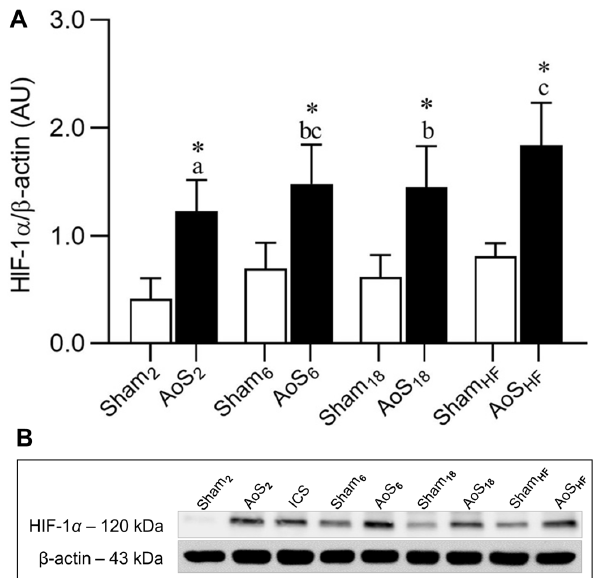
Figure 4. Hypoxia-inducible factor-1 α (HIF-1 α ) protein expression evaluated by Western Figure 4. Hypoxia ‐ inducible factor ‐ 1 α ( HIF ‐ 1 α ) protein expression evaluated by Western blot. ( A )